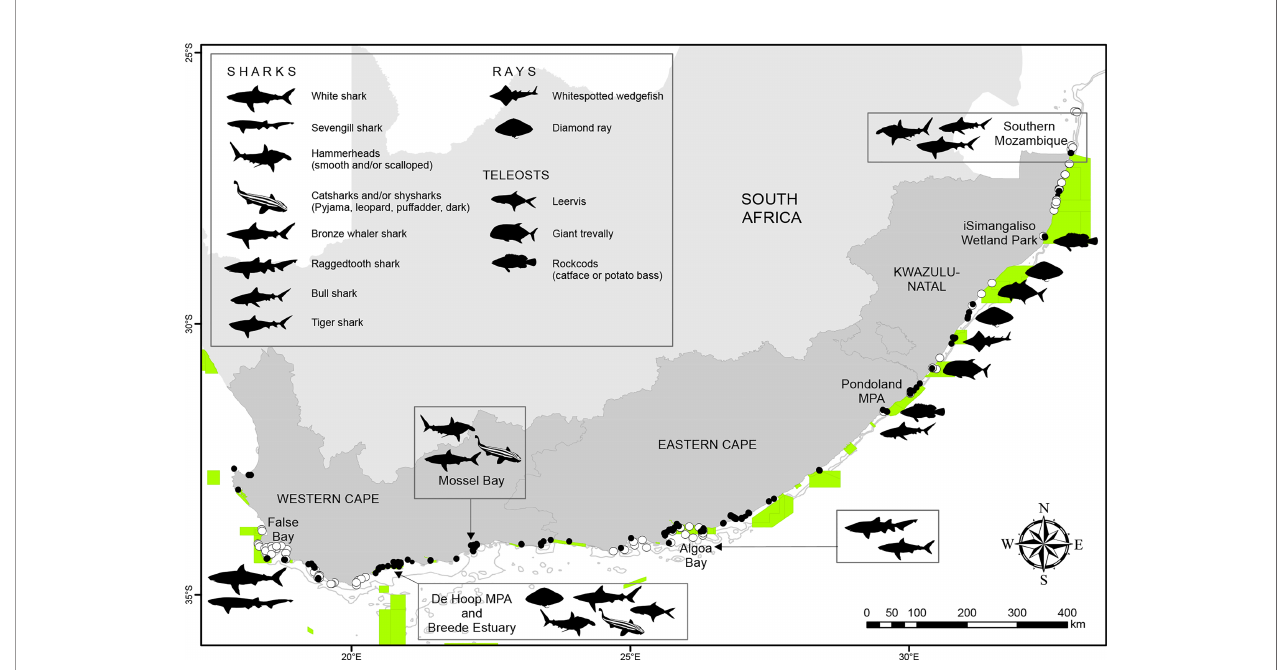
FIGURE 6 | The current MPA network in South Africa (green areas) covers approximately 5.4% of the country Exclusive Economic Zone. The majority of smaller research projects in the country are taking place in inshore MPAs, with focal study species (presented as silhouettes) being placed near the relevant MPAs. Note that not all focal species per region are shown. ATAP receivers are indicated by black dots and ATAP partner receivers are indicated by white dots.